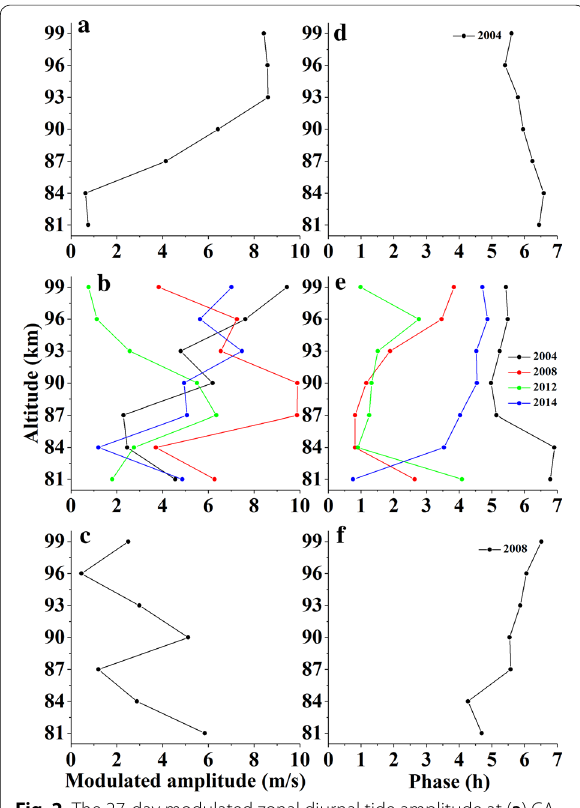
Fig. 2 The 27-day modulated zonal diurnal tide amplitude at ( a ) CA, ( b ) CP and ( c ) SM. Corresponding phases of the 27-day amplitude modulation are shown at ( d ) CA, ( e ) CP and ( f ) SM